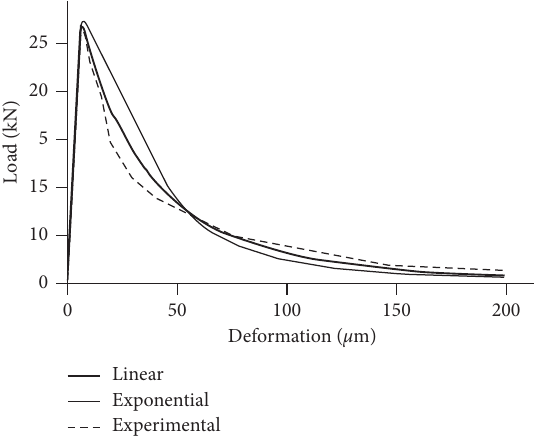
Figure 13: Deformation versus load.